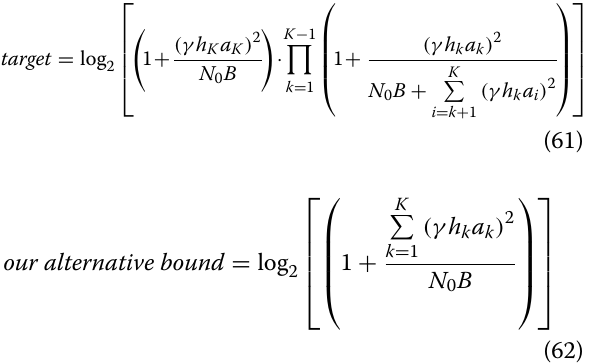
For NOMA strategies, this subsection discusses the approximate function property between the original tar- get of (61) and our alternative target of (62). Figure 4 is obtained to analyze the performance difference between the two